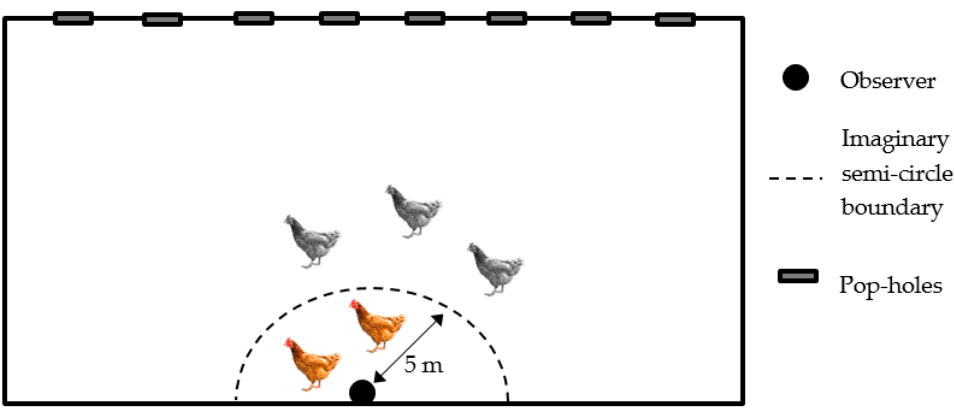
Figure 1. Schematic drawing of imaginary semi-circle boundary used for group behavioural observations of broiler chickens on organic farms.